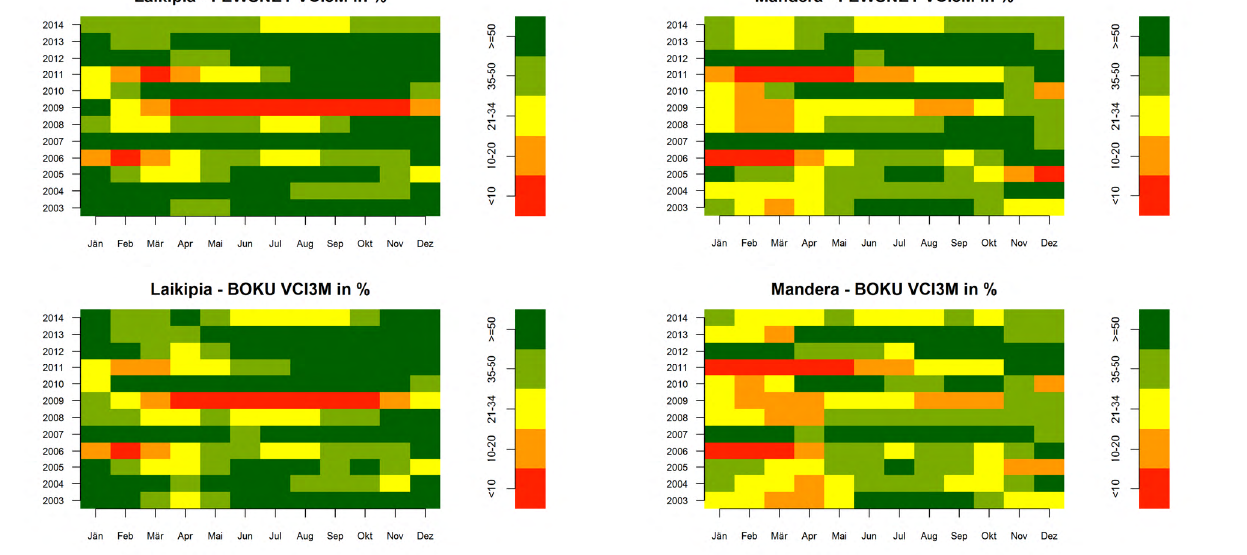
Figure 8: Seasonal matrix plot of categorised monthly VCI3M anomalies for the county of Laikipia (2003-2014) derived from (top) FEWS NET dataset and (bottom) BOKU dataset